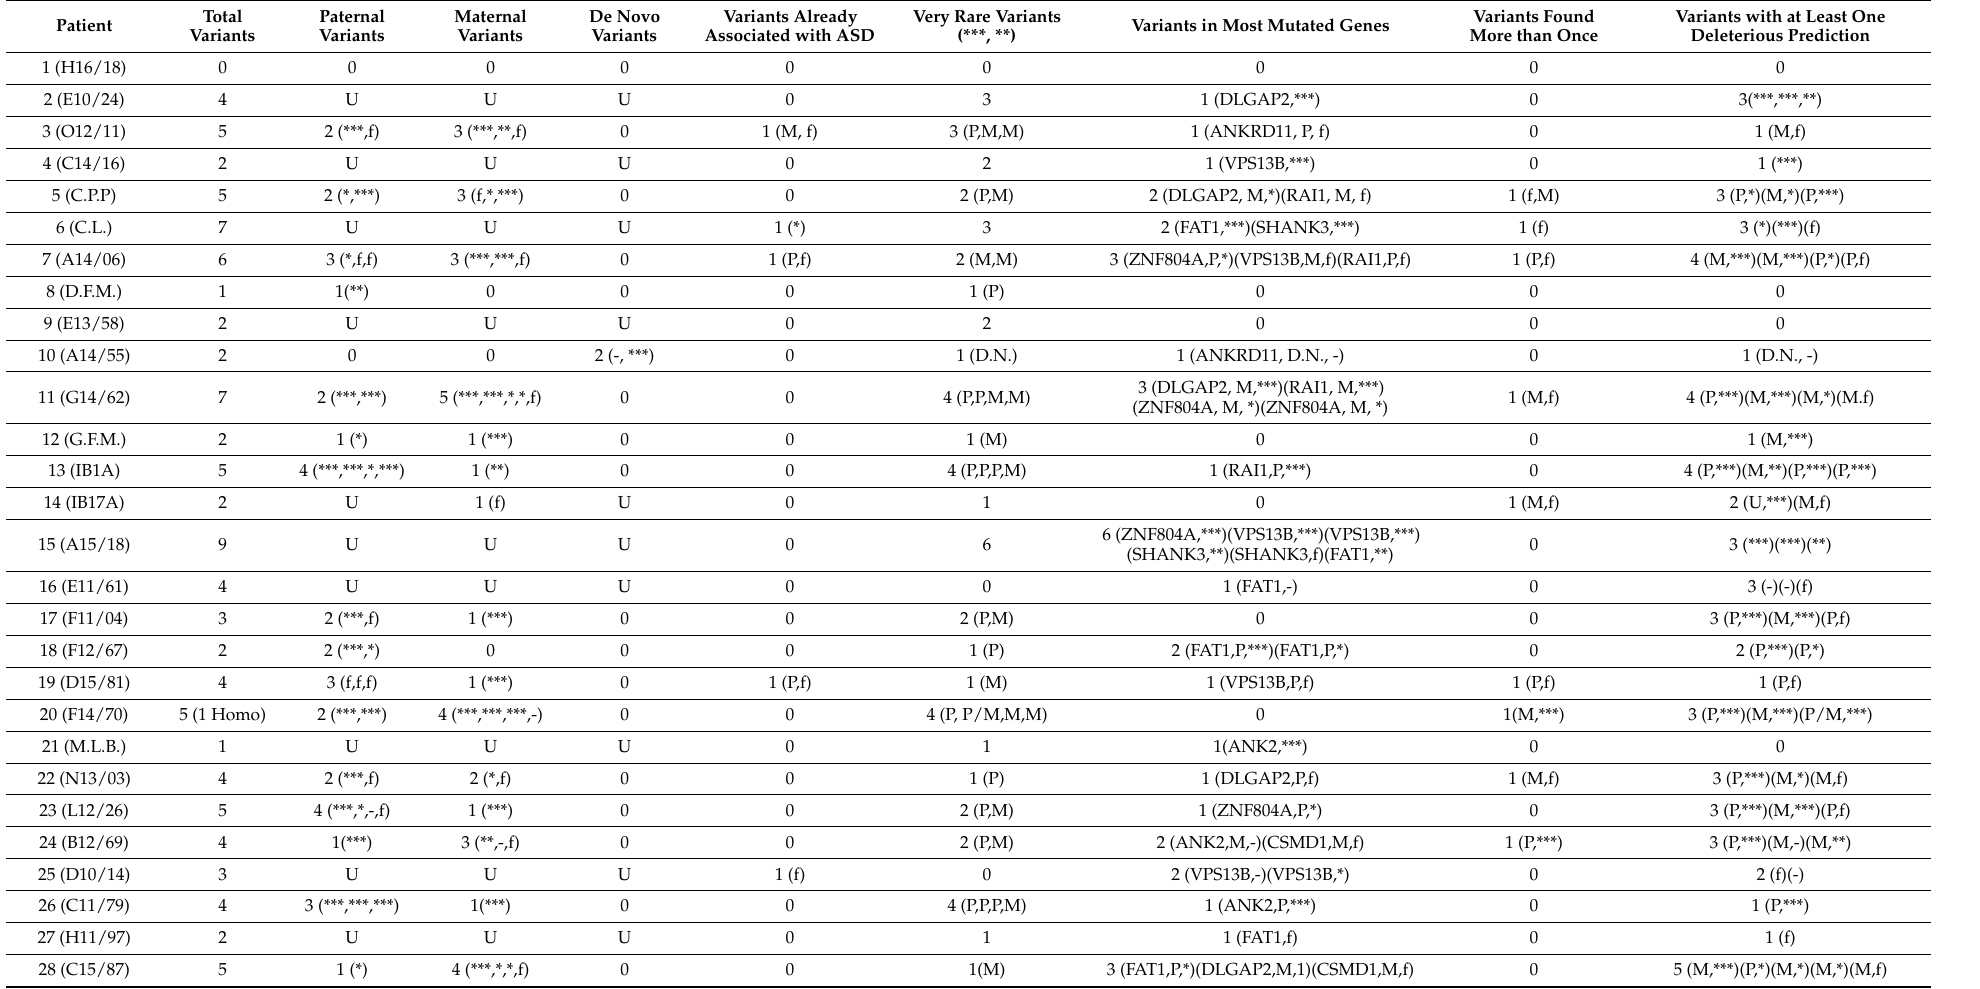
Table 4. Summary of all variants for each patient, with family segregation, frequency, and in vitro prediction